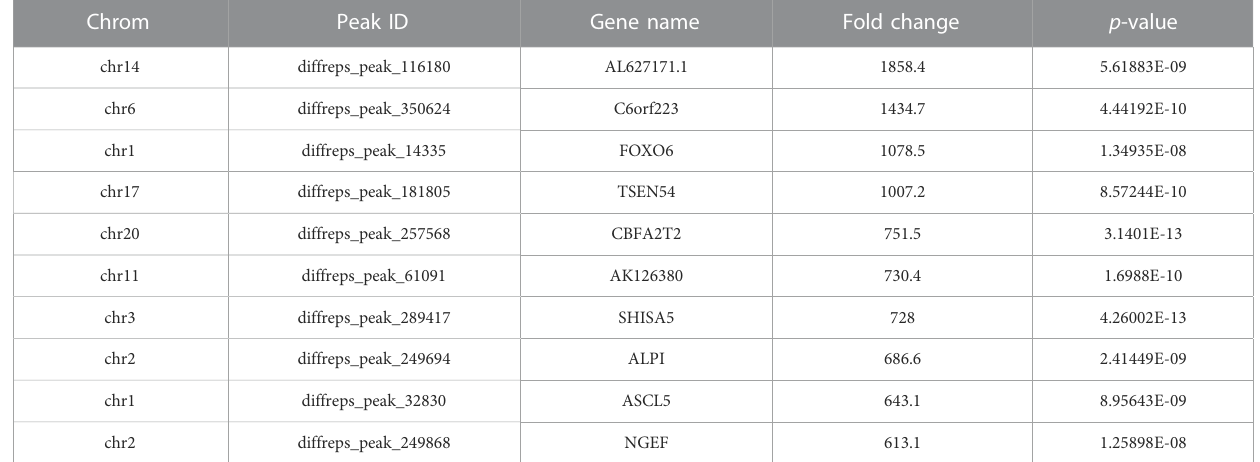
TABLE 2 Top Ten Downregulated m5C Methylation